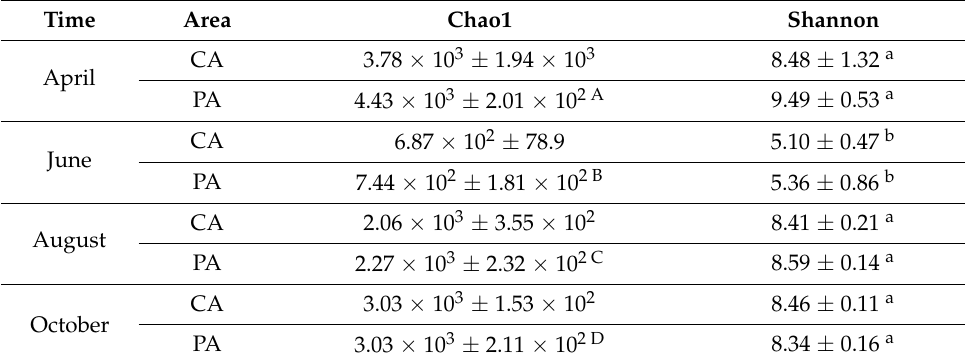
Table 3. Alpha diversity indices of microbial